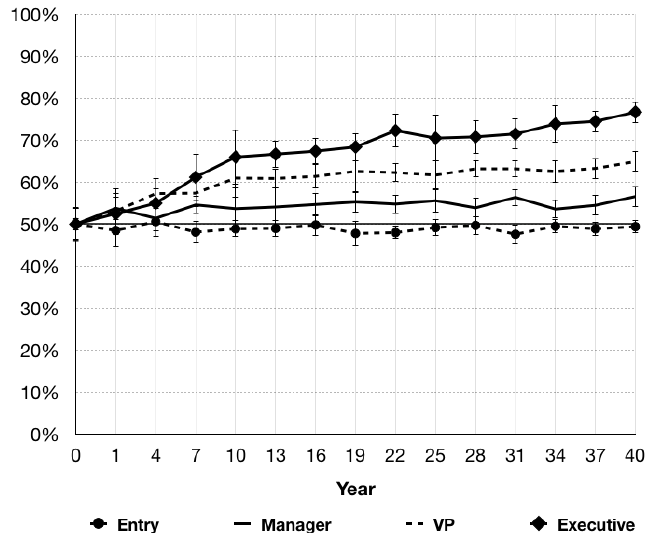
Figure 3. Fluctuations in gender balance across all four levels during a 40-year simulation when the promotion bias is 0.1.